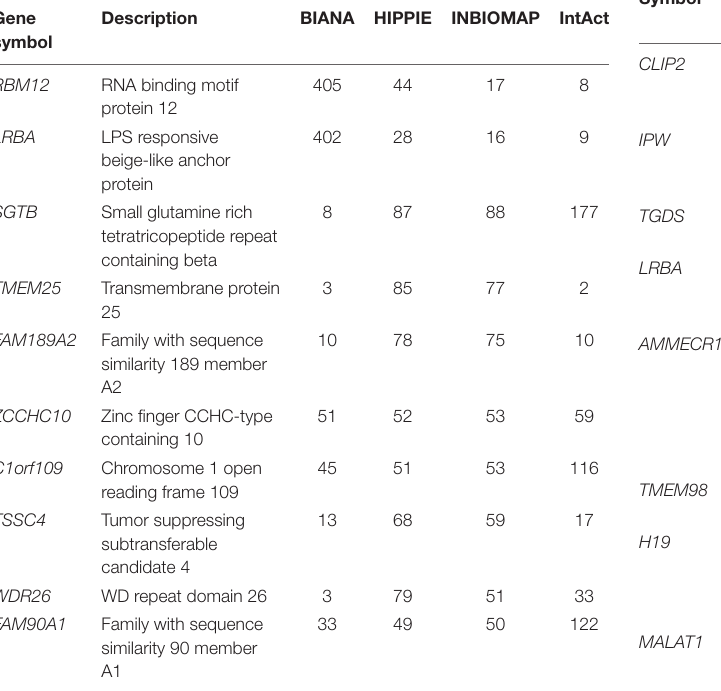
TABLE 3 | Degree of connectivity for top 10 genes in human protein–protein interaction databases.